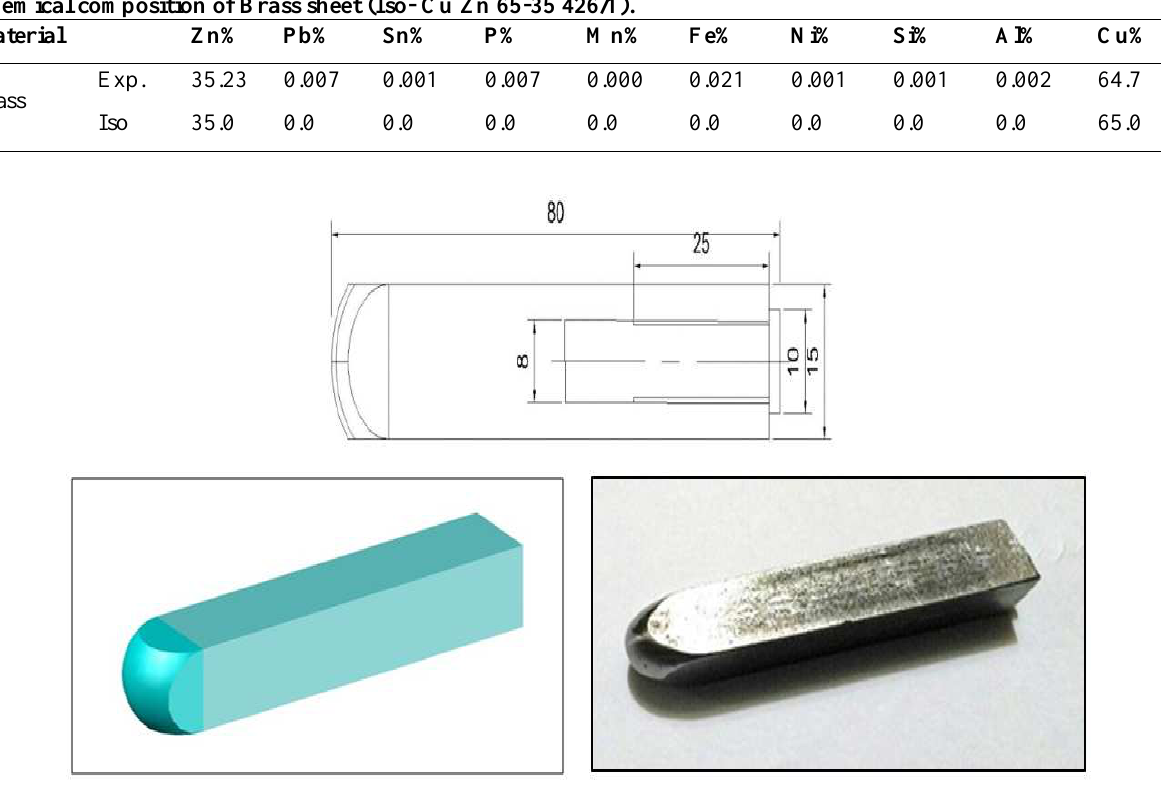
Fig. 2. Geometry of the forming tool (all dimension in